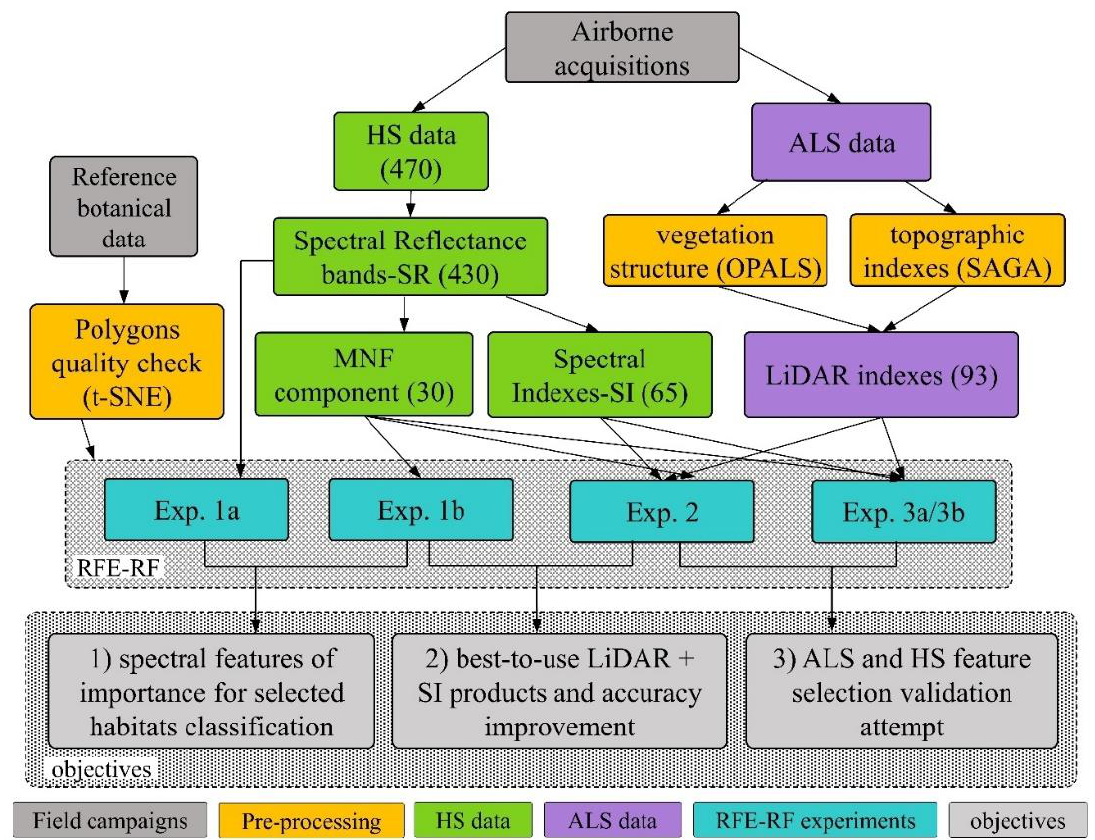
Figure 5. Flowchart of RS data pre-processing steps, the experiments design and the corresponding addressed objectives in the paper. Meaning of colored boxes are explained by the bottom-line boxes.